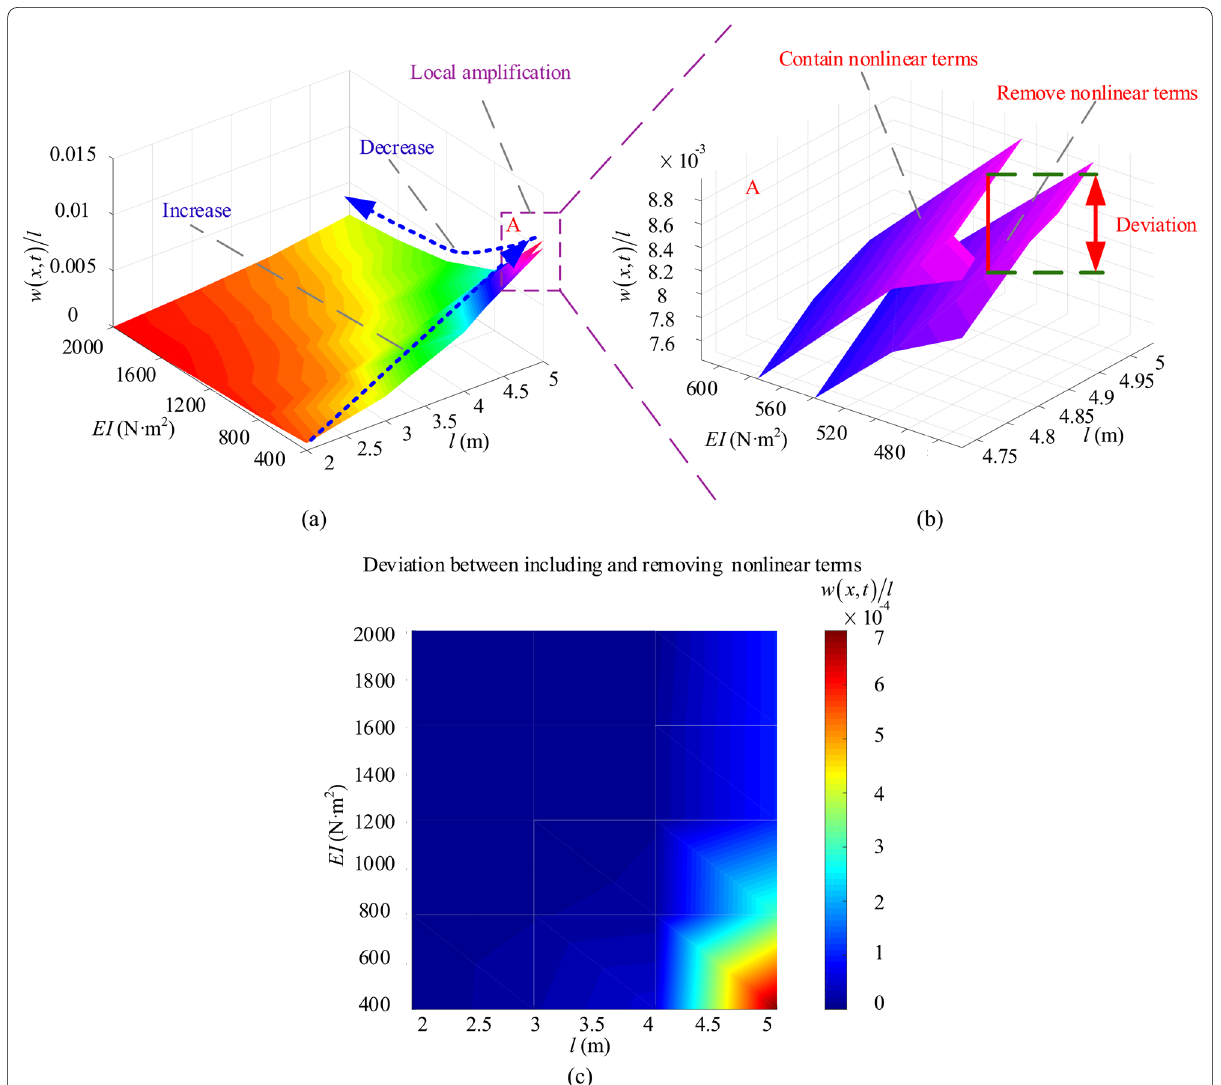
Figure 3 Deformation of flexible manipulators at low speed: ( a ) Relationship between deformability and length as well as flexural rigidity, ( b ) Partial enlarged view of ( a ), ( c ) Influence of nonlinear terms on